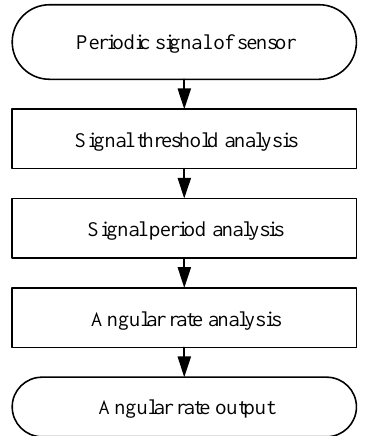
Figure 2. Composition of the angular rate electronic solver module.